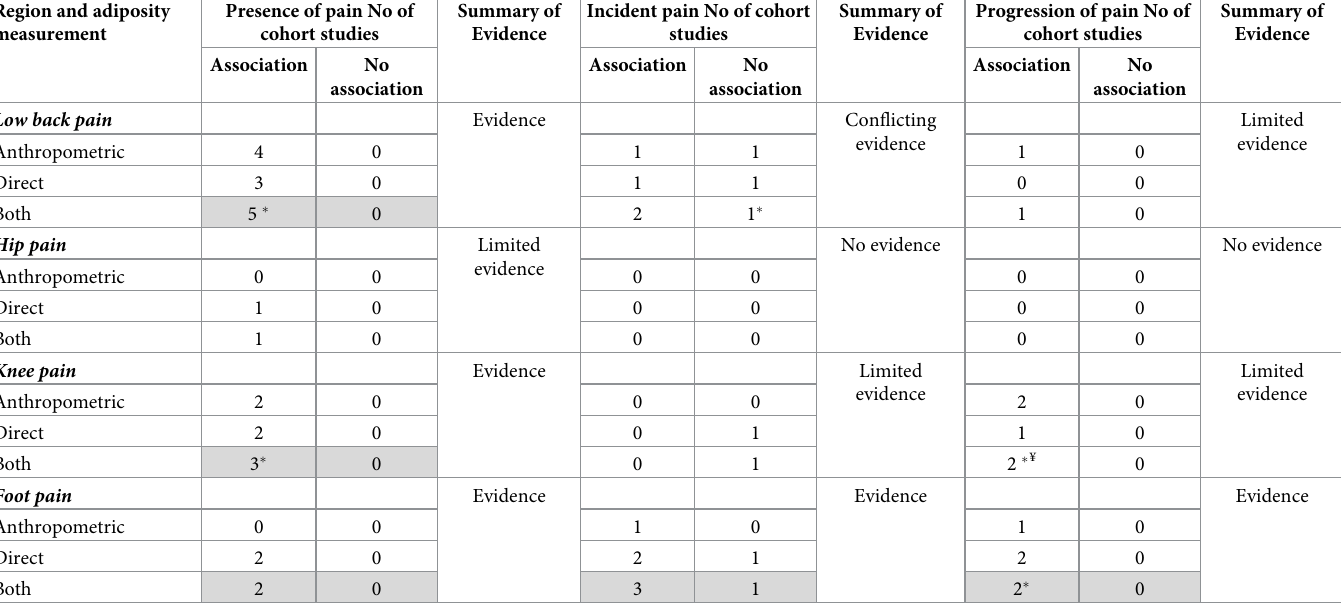
Table 4. Summary of evidence from cohort studies examining the longitudinal relationship between adiposity and the presence of pain, incident pain and progres- sion of